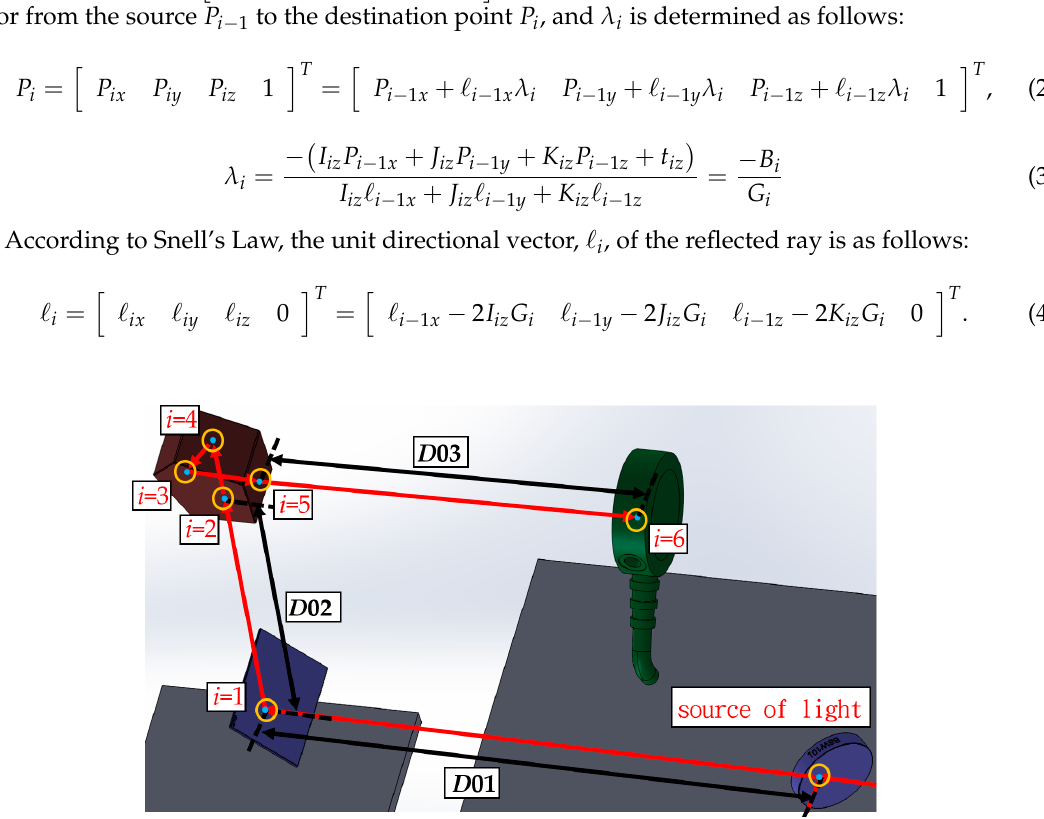
Figure 8. Example boundary surfaces of proposed measurement system.